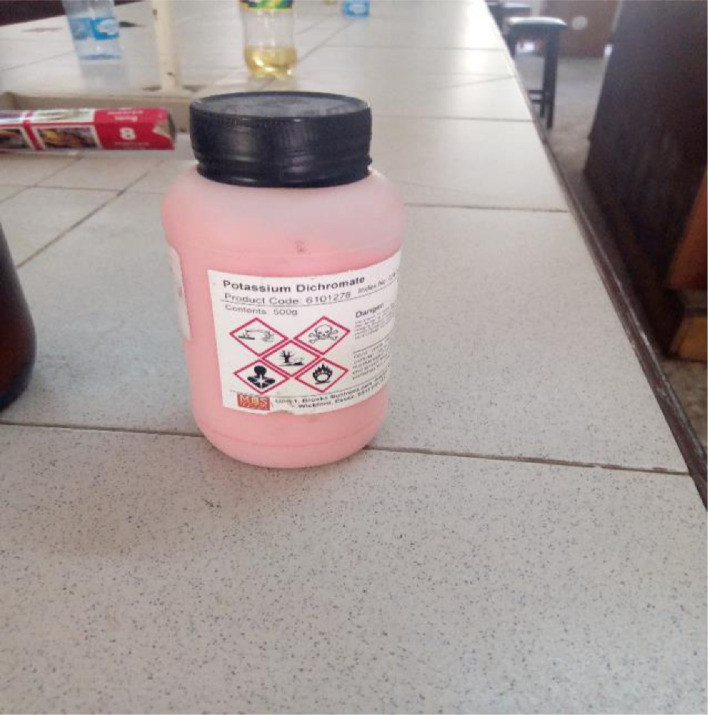
The Solid state of Kr2Cr2O7.